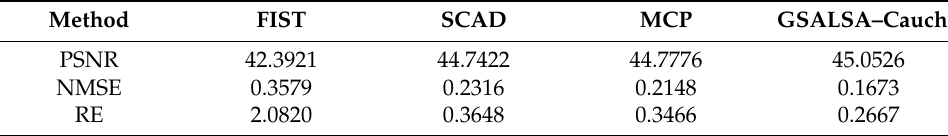
Table 2. PSNR, NMSE and RE of aircraft model under 75% sampling.